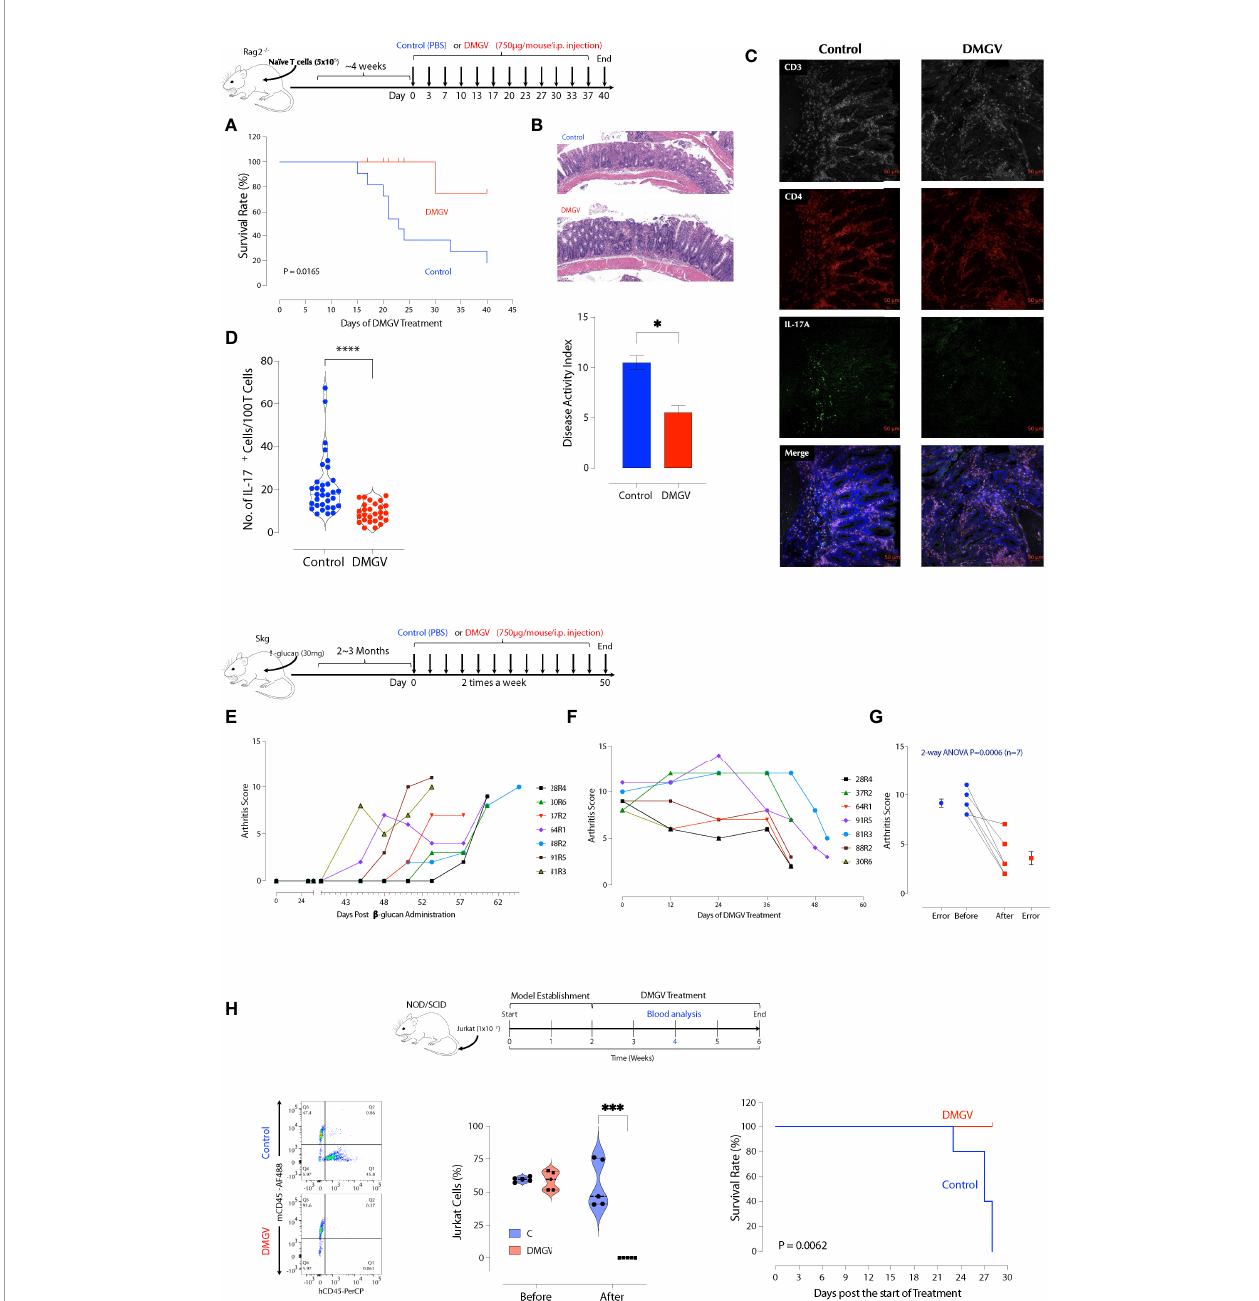
FIGURE 6 | DMGV suppresses in fl ammation in animal models of IBD and RA. (A) RAG2 -/- de fi cient BALB/c mice were injected i.p. with 5x10 5 naïve CD4 + T cells from BALB/c mice. Mice showing loose stool were immediately treated with PBS or DMGV (750µg in water/mice) i.p. twice a week. The experiment was terminated after 40 days of treatment. The statistical signi fi cance was calculated with the Kaplan-Meier method. (B) The representative colon H&E staining shows that the control group had more severe in fl ammation (ulceration, immune in fi ltrates) compared to the treated group. The disease activity index was measured as previously described (49). (C) The representative IL-17A staining in the colon section. (D) The morphometric analysis in the colon section shows a signi fi cant reduction in the IL-17A + cell counts after the DMGV treatment. (Each dot represents a single confocal micrograph.) (E) SKG mice (n=16) were injected with laminarian ( b -glucan, 10mg/mouse) and the arthritis score was measured weekly. Mice reaching the threshold score of 8 were selected and immediately treated with DMGV. (F) The selected mice (n=7) were administered i.p. with DMGV (750µg in water/mouse) twice a week. The experiment was terminated at the same time although the treatment started at different time points. (G) The statistical signi fi cance was calculated with 2-way ANOVA. (H) DMGV eliminates T cell leukemia in a mouse model. The model (Top panel) was generated by injecting 1x10 7 Jurkat cells per NOD/SCID mouse i.v. and measuring the Jurkat to mouse CD45 + cell ratio in the peripheral blood after 2 weeks by fl ow cytometry. PBS or DMGV was injected as indicated and the fi nal analysis was made after 2 weeks of treatment. The same results were obtained in two separate experiments. * < 0.05, *** < 0.001, **** <